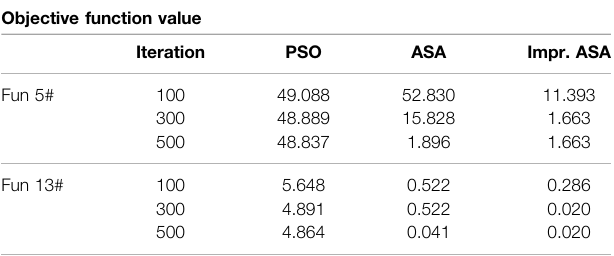
TABLE 2 | Evolution of the objective function during the optimization of two test functions by three optimization algorithms. Objective function